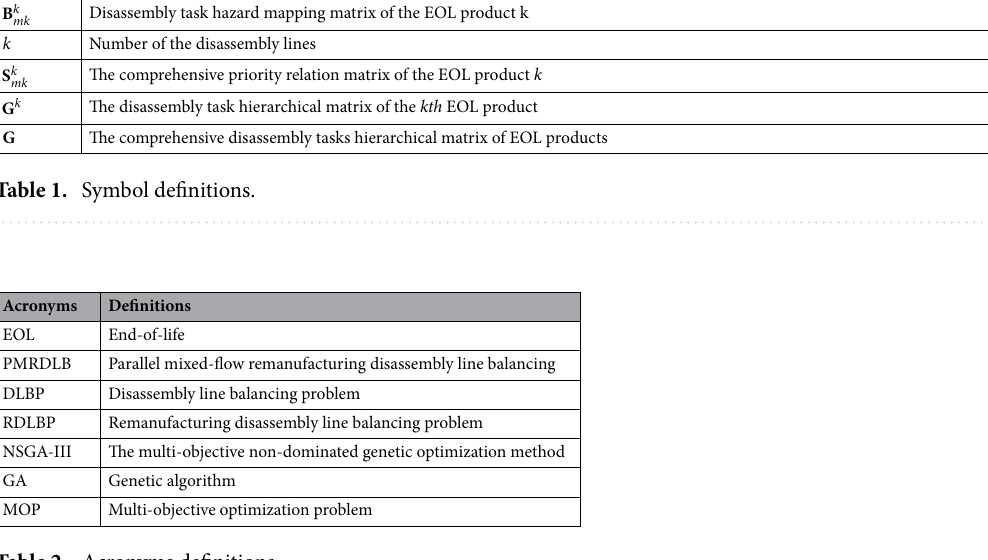
Table 2. Acronyms